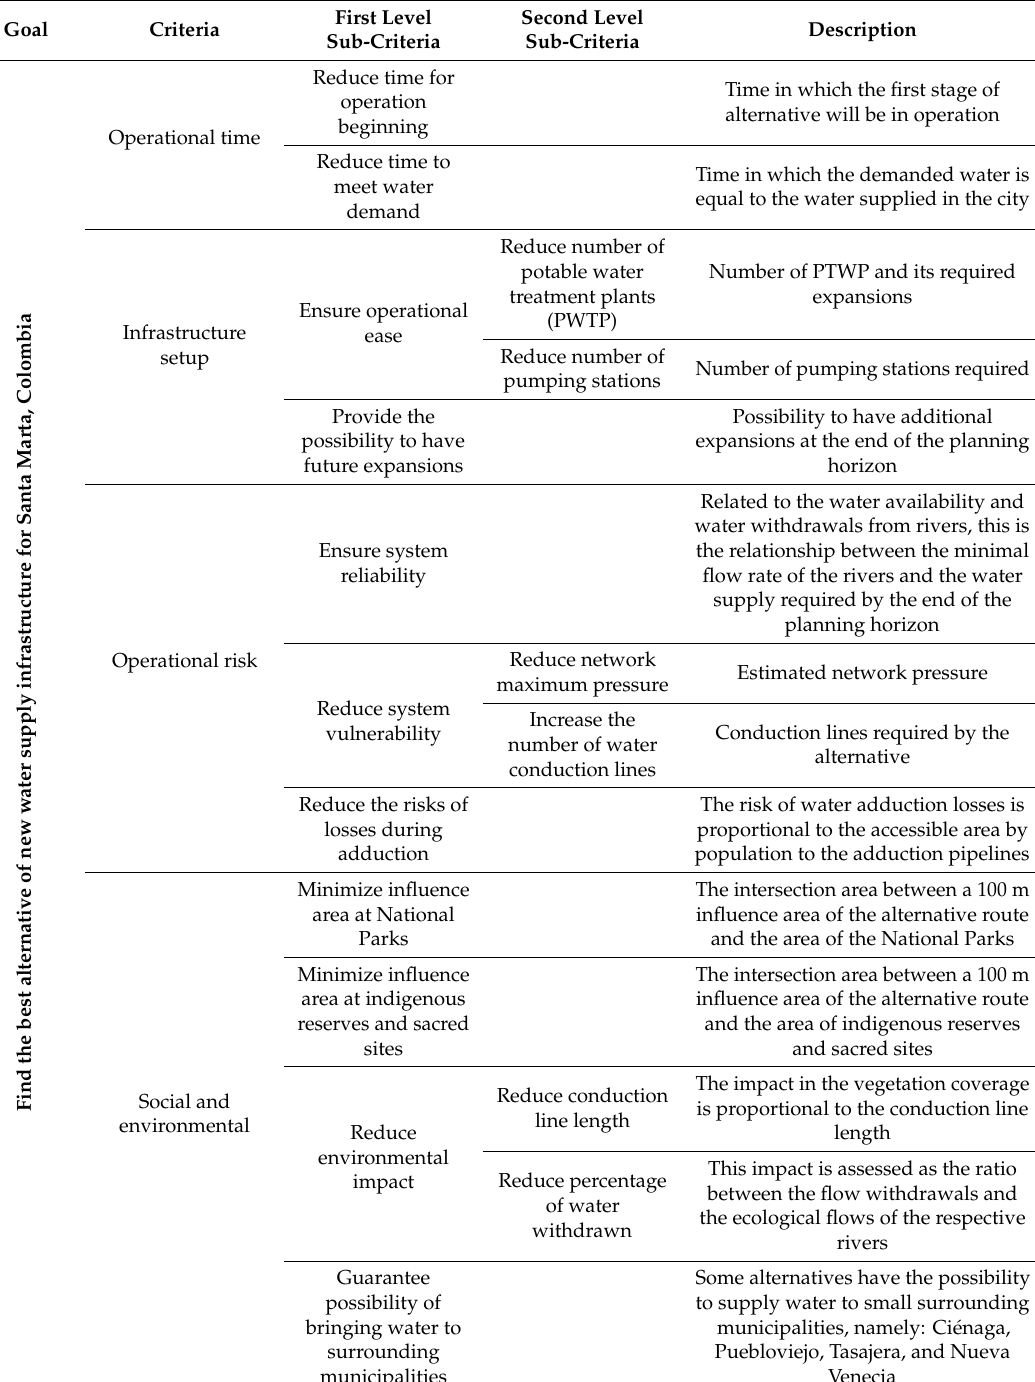
Table 1. Global goal, criteria, and sub-criteria